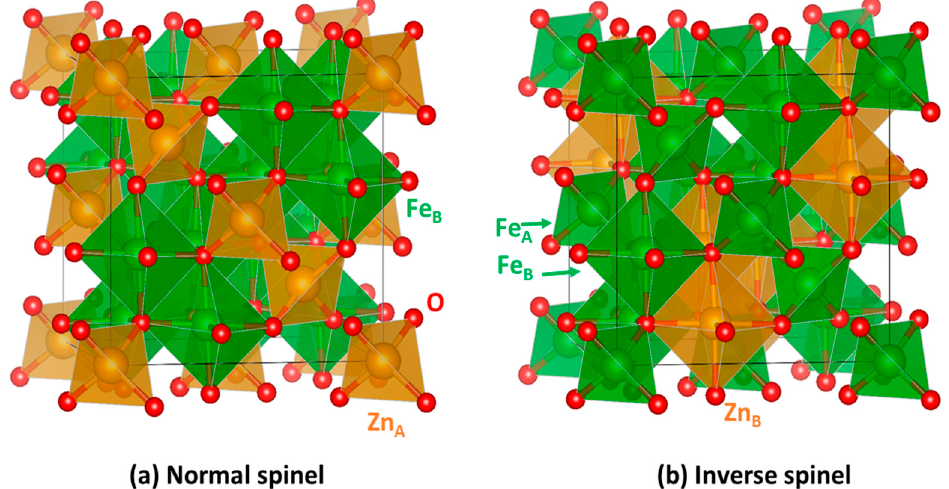
Figure 1. Atomic structure of the spinel zinc ferrite with ( a ) normal and ( b ) inverse cation distribu- tions. In each case, the conventional cubic cell (with 8 f.u. of ZnFe 2 O 4 ) is delimited by solid black lines. Tetrahedral (A) and Octahedral (B) atomic coordination environments can also be identified by their polyhedra. Orange, green, and red atoms correspond to Zn, Fe and O chemical elements, respectively.